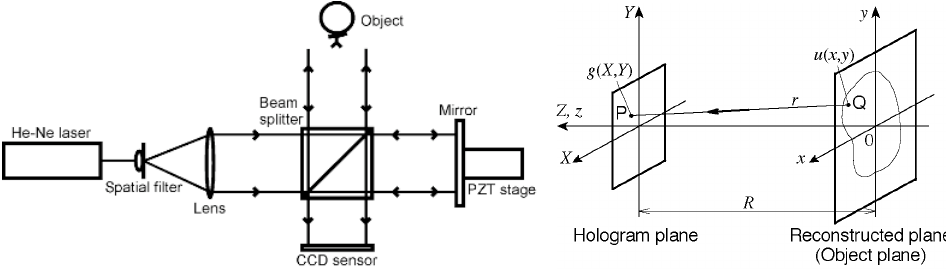
Fig. 1. Twyman-Green type interferometer Fig. 2. Diffraction for phase-shifting digital